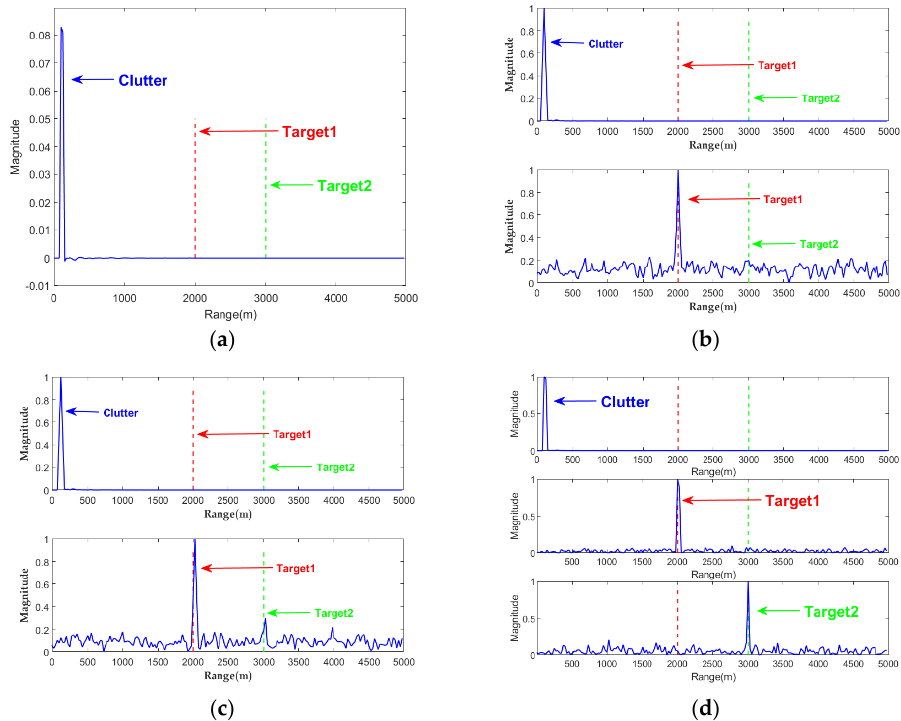
Figure 10 . The clutter suppression results for TPC, SPC, and PPSA. ( a ) Echo data, ( b ) the result of